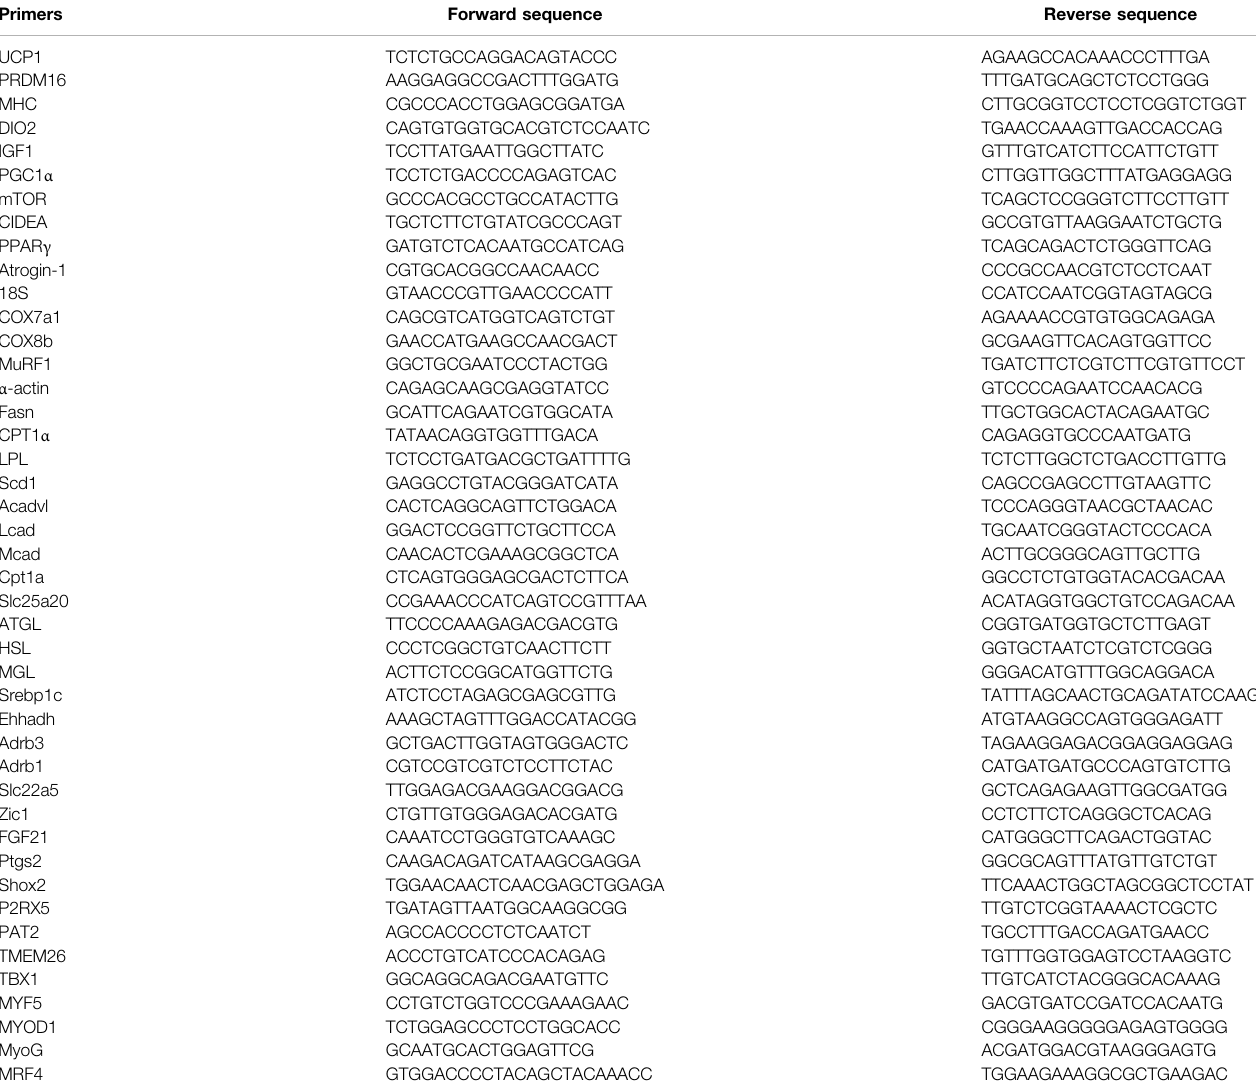
TABLE 1 | Primer sequences for real-time